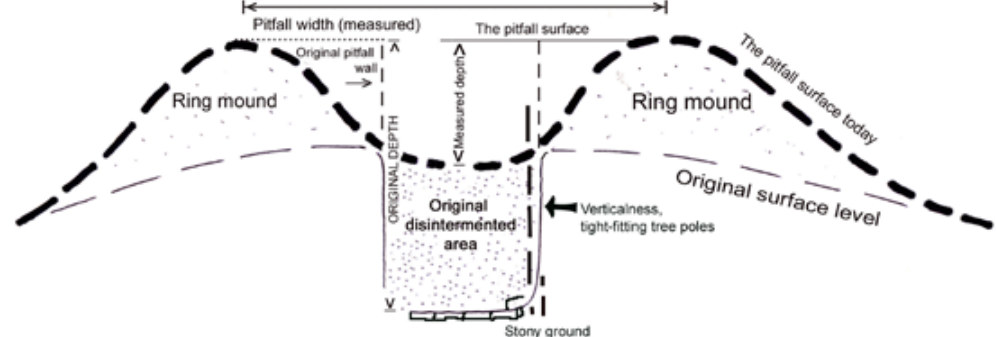
Fig. 3. Original and present shape displayed in a schematic cut of a pitfall. Models of the current surface shape of pitfall remains indicating how measurements were taken (Jordhøy,